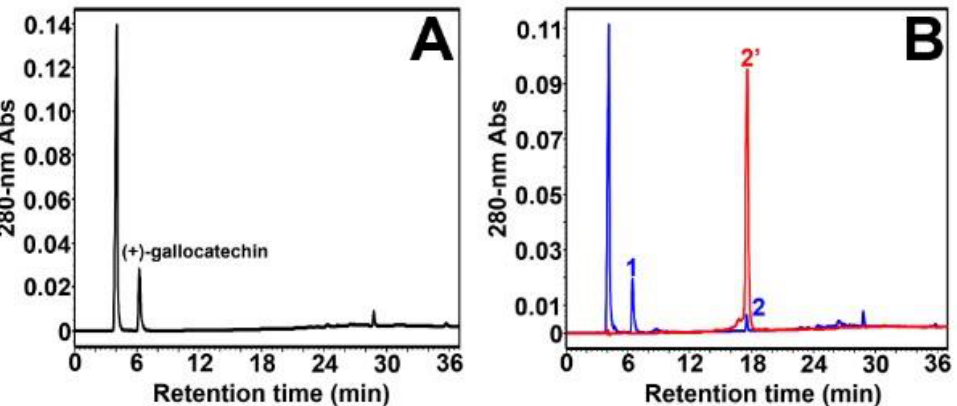
Figure 6. Reverse-phase HPLC analysis of Vv ANS product of (+)-gallocatechin. ( A ) HPLC analysis of the reaction mixture containing 100 µM (+)-gallocatechin without enzyme. (+)-Gallocatechin is eluted at 6.2 min, and no product is observed; ( B ) HPLC overlay chromatogram of the enzymatic products of (+)-catechin (in red) and the commercial standard of 100 µM cyanidin chloride (in blue). The blue peak 1 corresponds to (+)-gallocatechin (residual). The two large peaks observed at 4.0 min in ( A ) and ( B ) correspond to ascorbate.